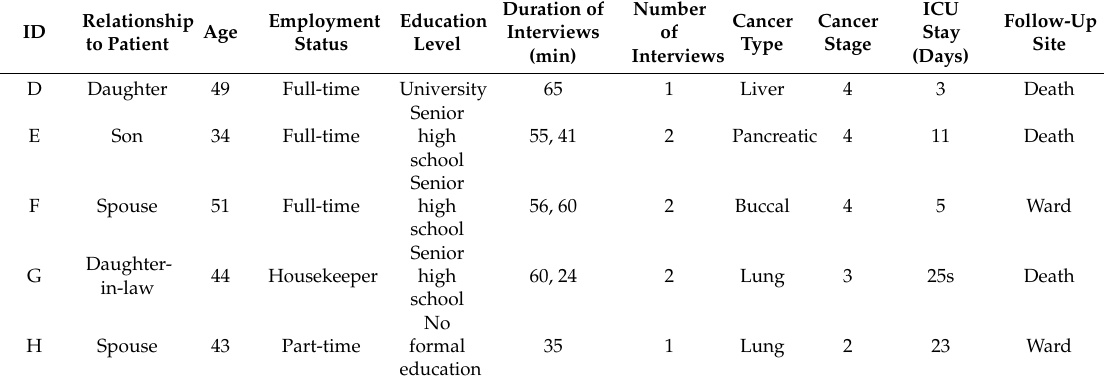
Table 1. Characteristics of surrogates and patients (n = 8).